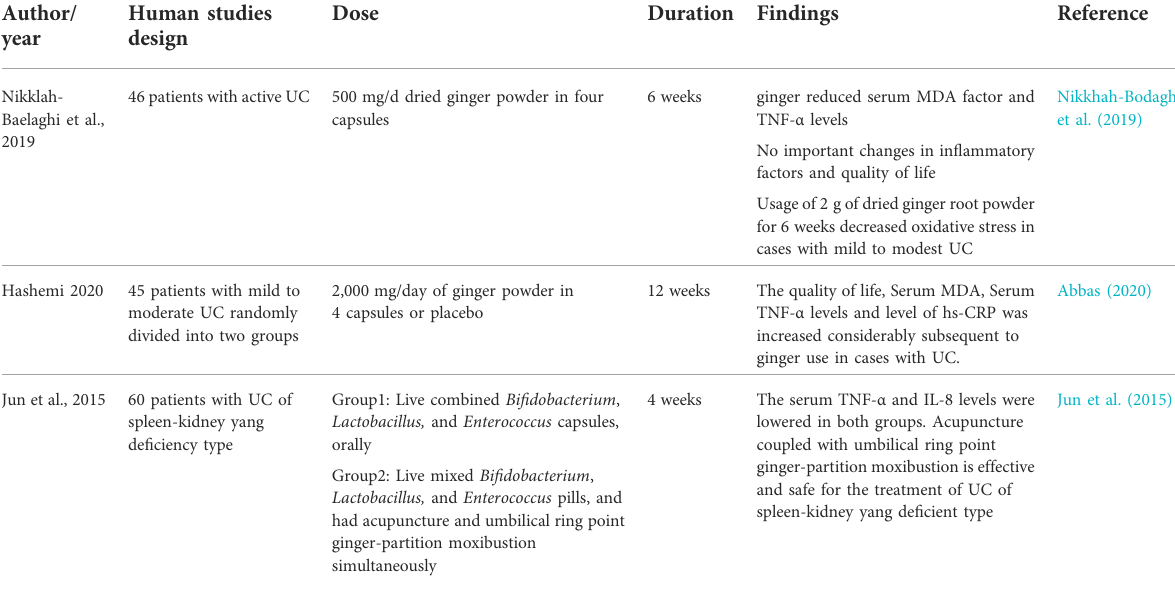
TABLE 3 The characteristics of the included human studies on the effect of ginger in